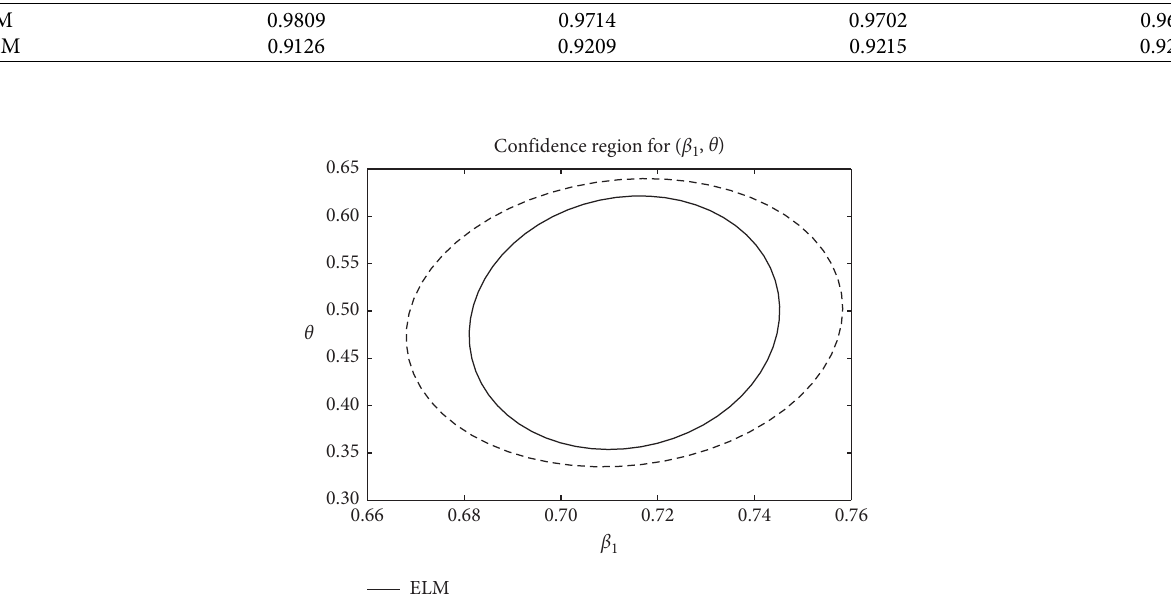
, θ ) when the nominal level is 0.95, 1